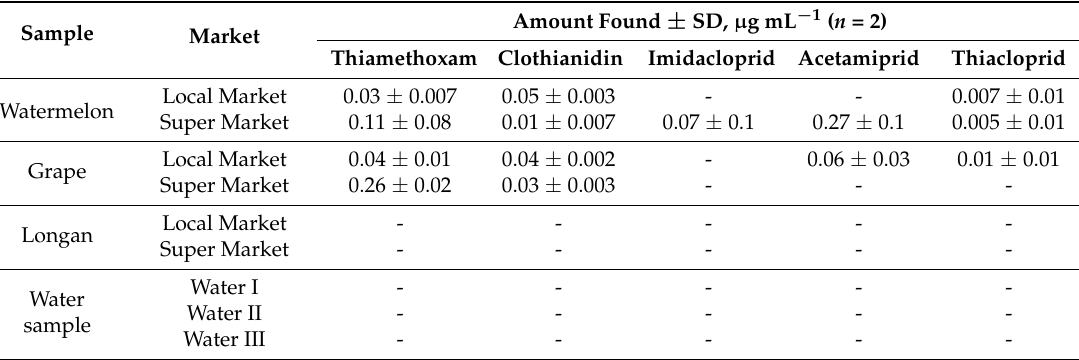
Table 2. Analysis of neonicotinoid insecticides in real